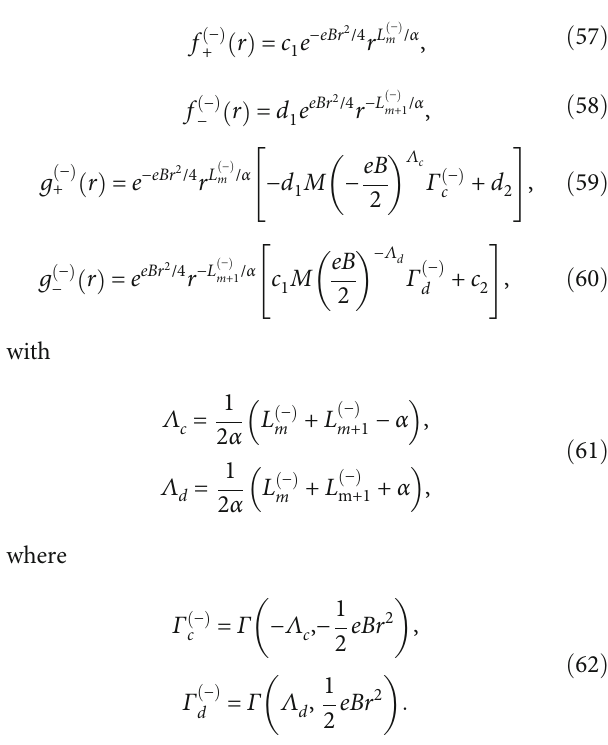
Figure 1: Sketch of the energy levels E ð > Þ function of the magnetic fi eld B for di ff erent values of n . The positive energies are represented by solid lines and the negative by dashed